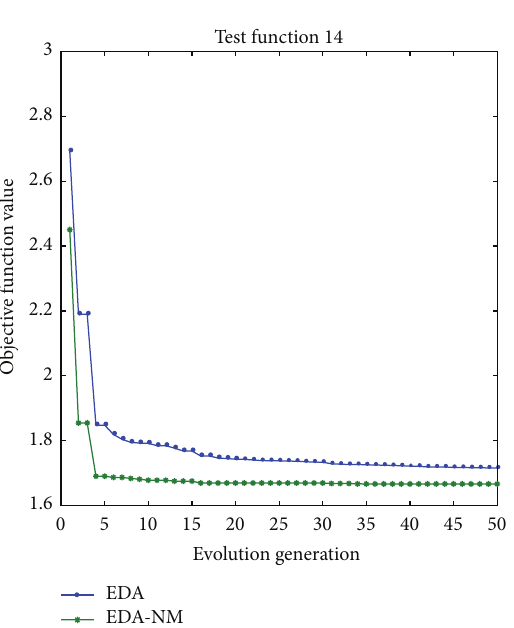
Figure 3: Convergence figure on test problem 4.